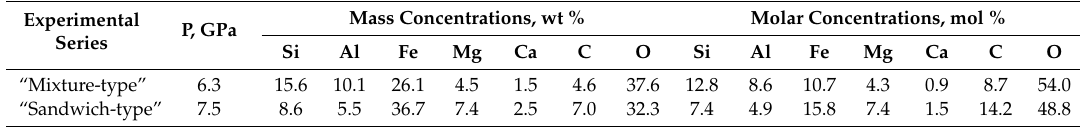
Table 2. Bulk compositions of the carbide–oxide–carbonate